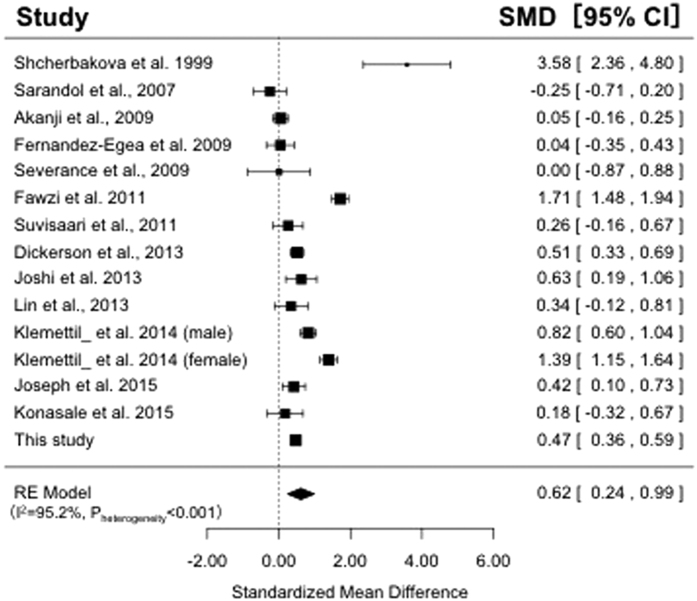
Meta-analyses of case-control studies between serum CRP levels and schizophrenia.The results of the meta-analysis of fifteen case-control studies which measured serum CRP levels (N = 4,734). The serum CRP levels were significantly higher in patients with schizophrenia than in the controls (SMD = 0.62; 95% CI, 0.24–0.99; p = 1.4 × 10−3 in the random-effects model).